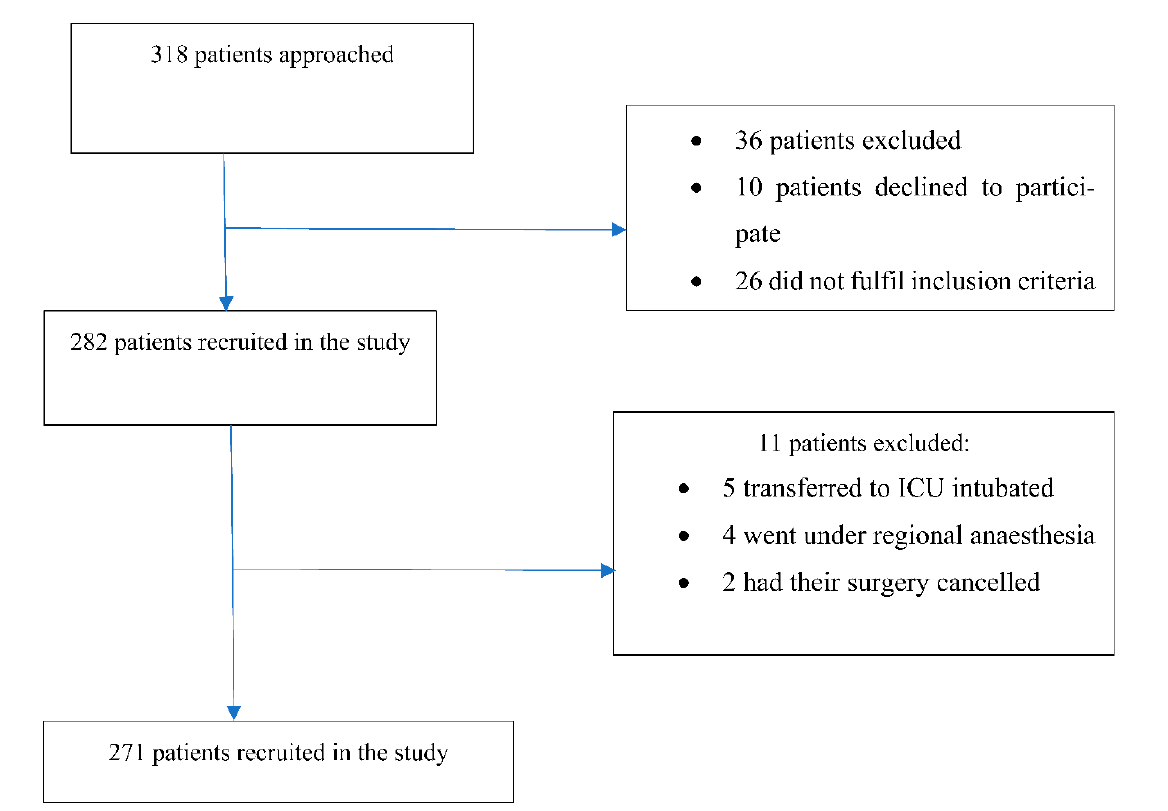
Figure 1. Participants who were included, excluded, and completed the study. Table 1. Baseline characteristics of participants by delirium diagnosis DSM-5 (definite delirium). All Participants ( n =